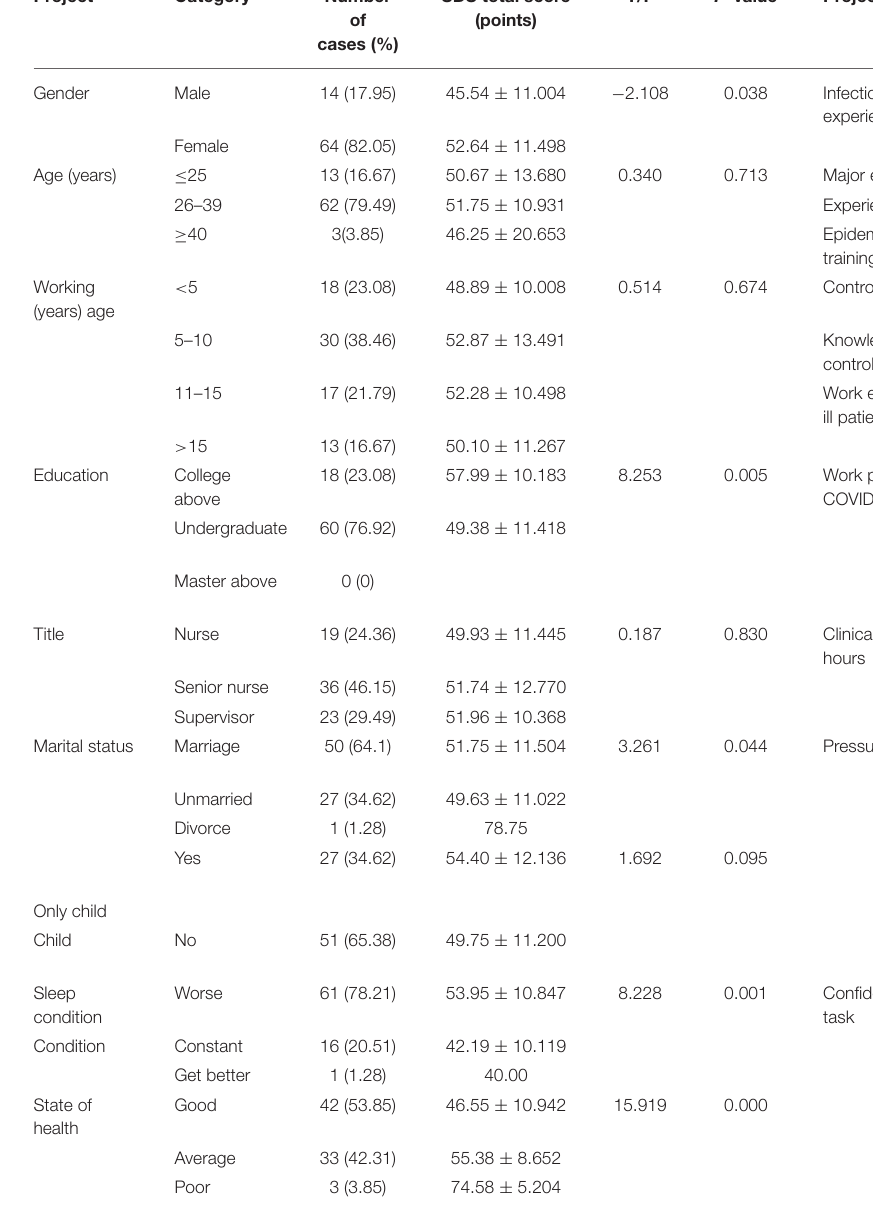
TABLE 1 | Univariate analysis of depression in ICU nurses combating COVID-19 pandemic (mean ± sd, n = 78).